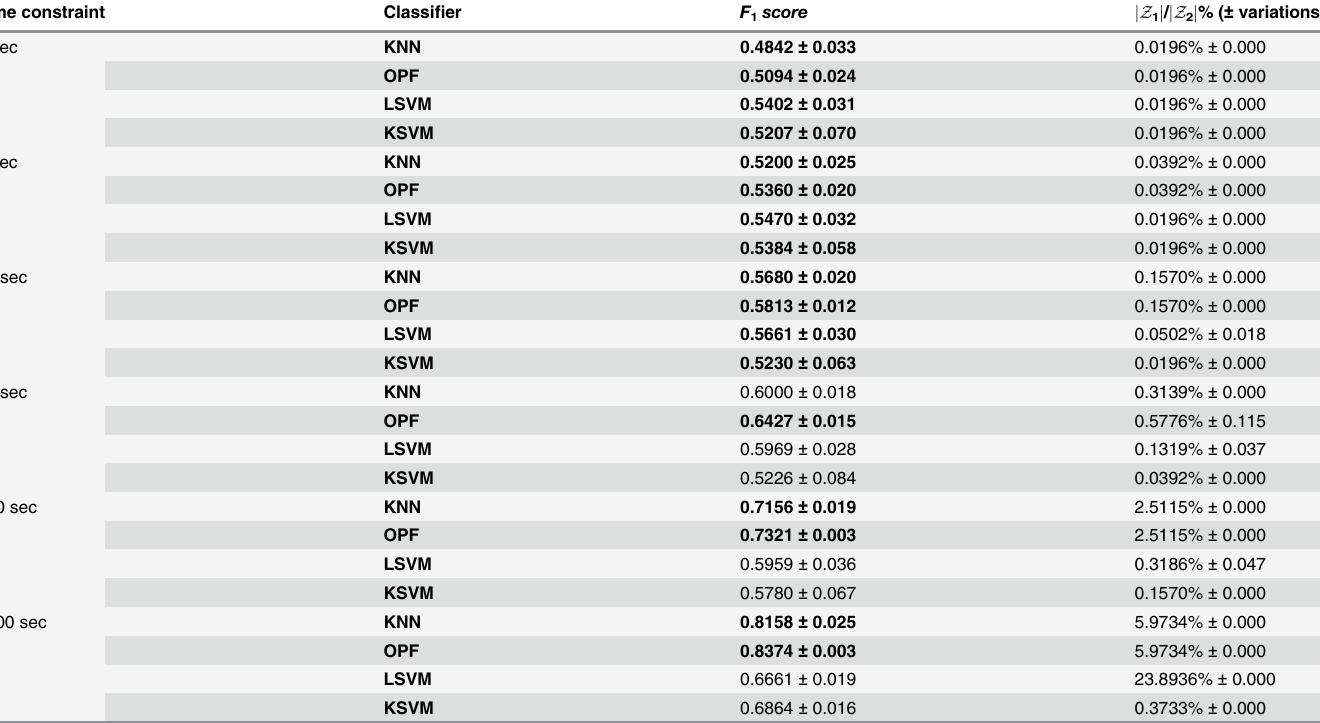
Table 4. Covertype dataset: Predictivity performance over Z 3 and final training set size, j Z 1 j as a percentual of j Z 2 j , for each classification model and learning time constraint using the proposed selection.